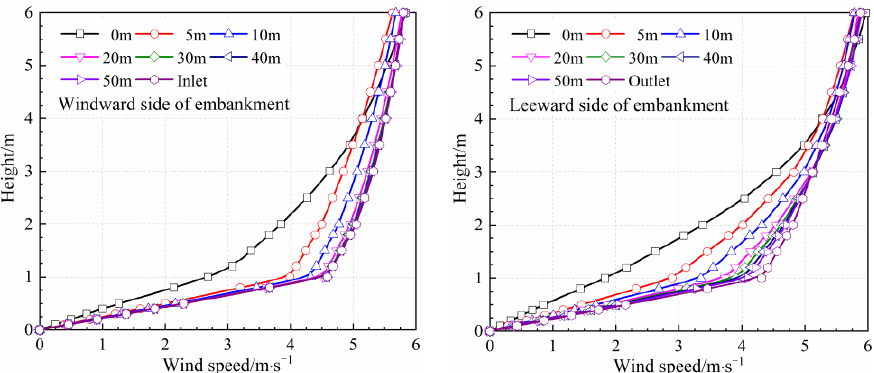
Figure 10. Distribution of the wind speed from the ground surface up to the height of 6 m on the windward and leeward sides of embankment.